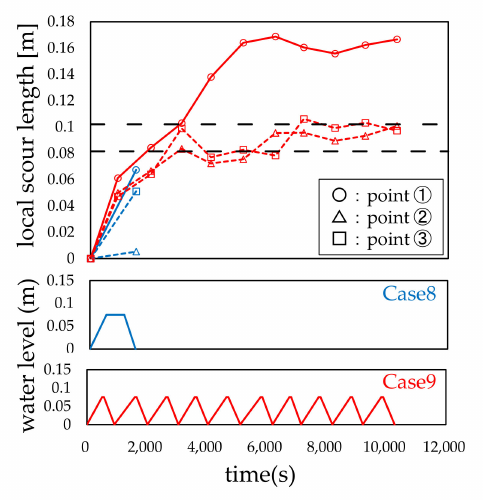
Figure 16. Local scour length of Cases 8 and 9.